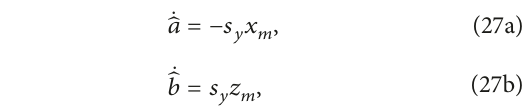
system (23a), (23b), and (23c) and slave system (24a),